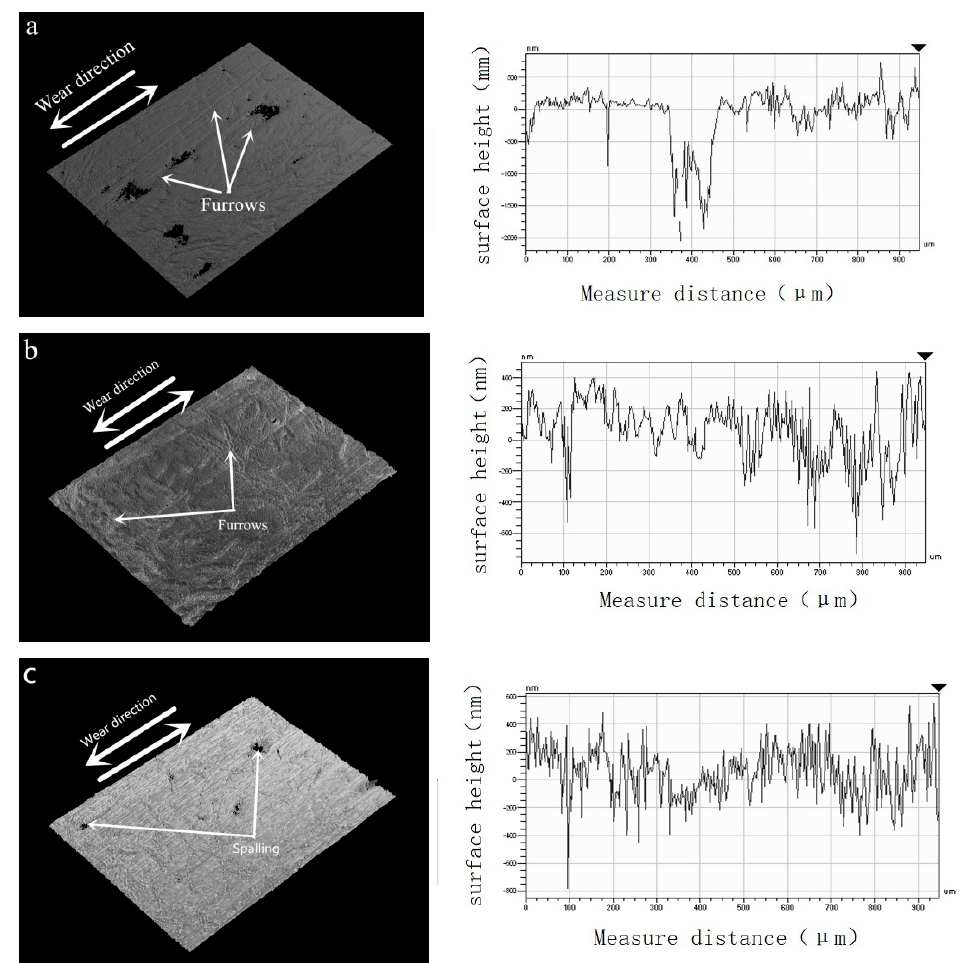
Figure 10. Surface morphology of brake drum specimen grinded with brake pad. ( a ) The surface morphology of the brake drum specimen grinded against the Semi-metallic Brake Pad; ( b ) the surface morphology of the brake drum specimen grinded against the organic asbestos-free brake pads; ( c ) the surface morphology of the brake drum specimen grinded against the organic asbestos-free brake pads.